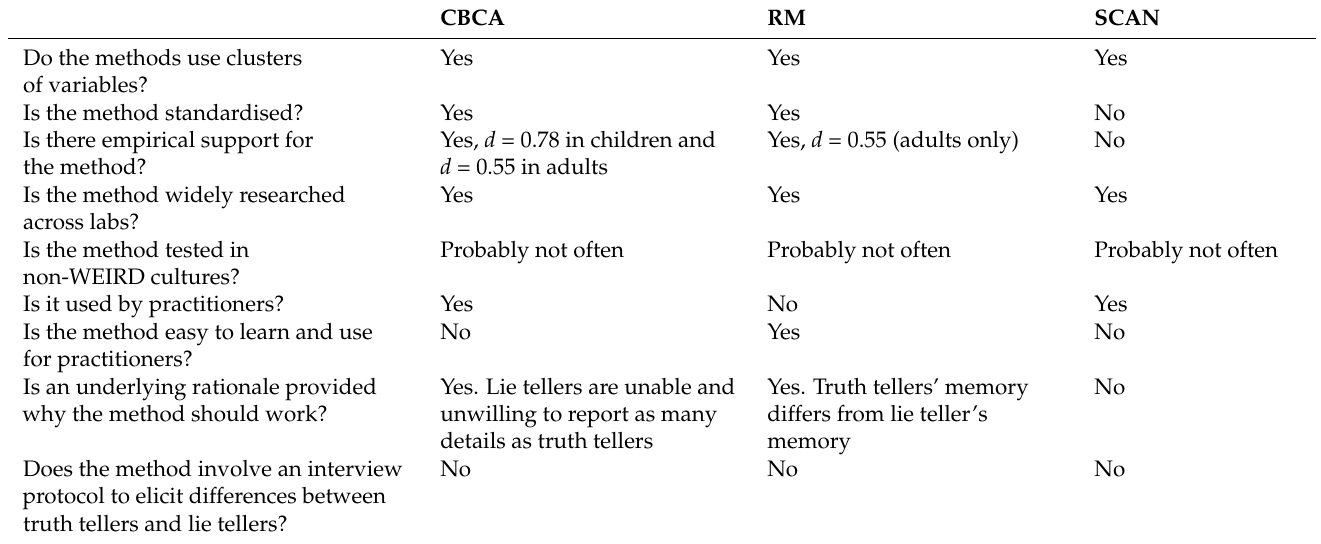
Table 1. A comparison between the CBCA, RM, and SCAN tools. CBCA RM